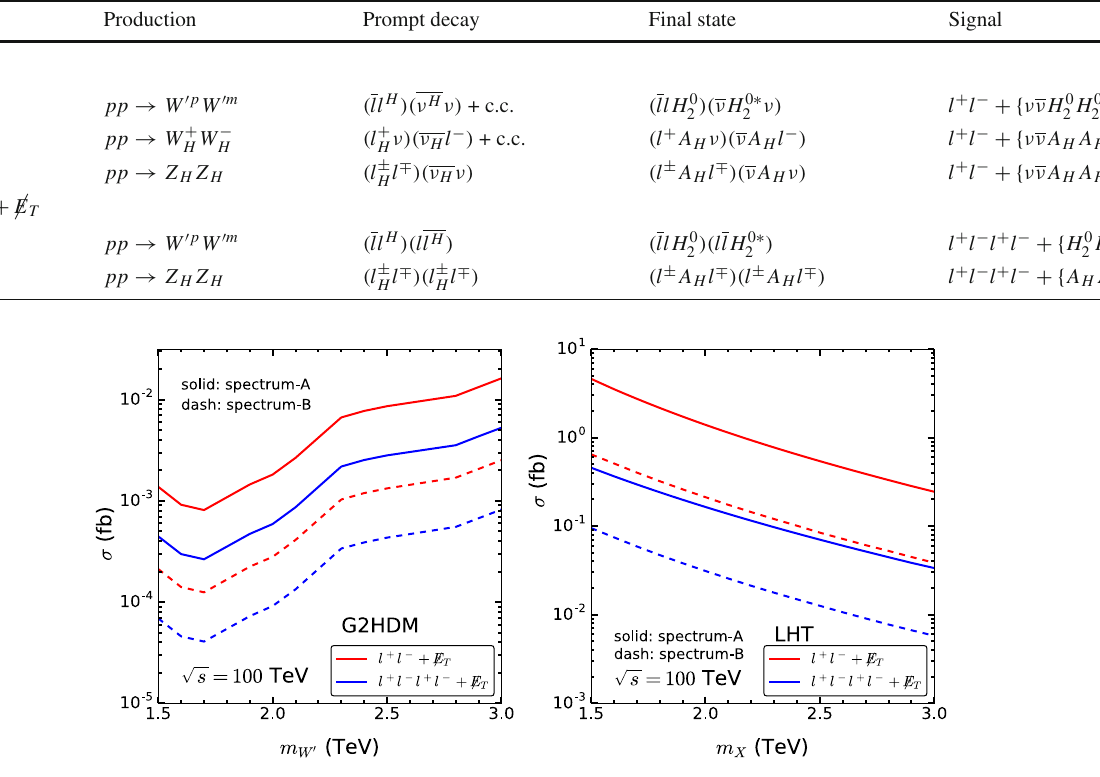
Fig. 4 Left panel: cross section σ (fb) versus the mass m W (cid:2) ( p , m ) (TeV) for 2 l + (cid:3) E T and 4 l + (cid:3) E T channels. The red/blue solid (dashed) lines are the cross sections of 2 l + (cid:3) E T and 4 l + (cid:3) E T channels computed at √ s = 100TeV predicted by Spectrum A (Spectrum B) in G2HDM,